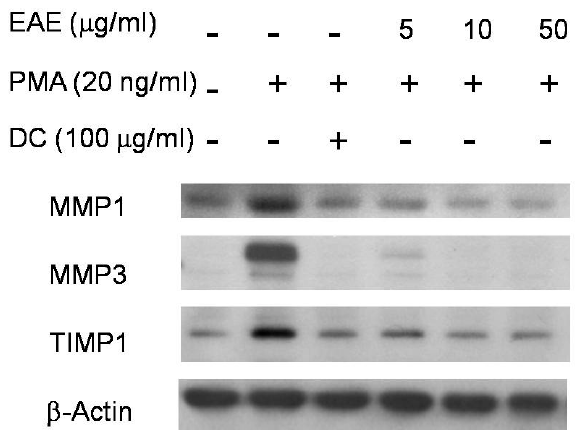
Figure 3. Western blotting was performed to compare cellular protein expressions. EAE altered the collagen-related protein levels. PMA was at 20 ng/mL as the negative control, and doxycyline (DC) was at 100 μ g/mL as the positive control.